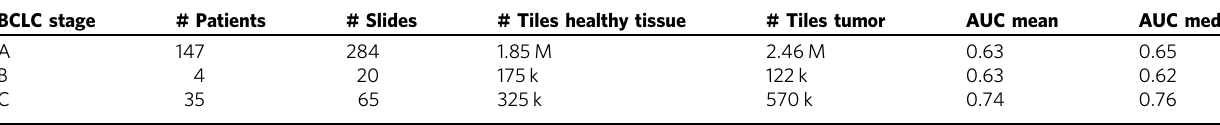
Table 3 Agreement between the predicted expression of MKI67 and the tumor annotation.